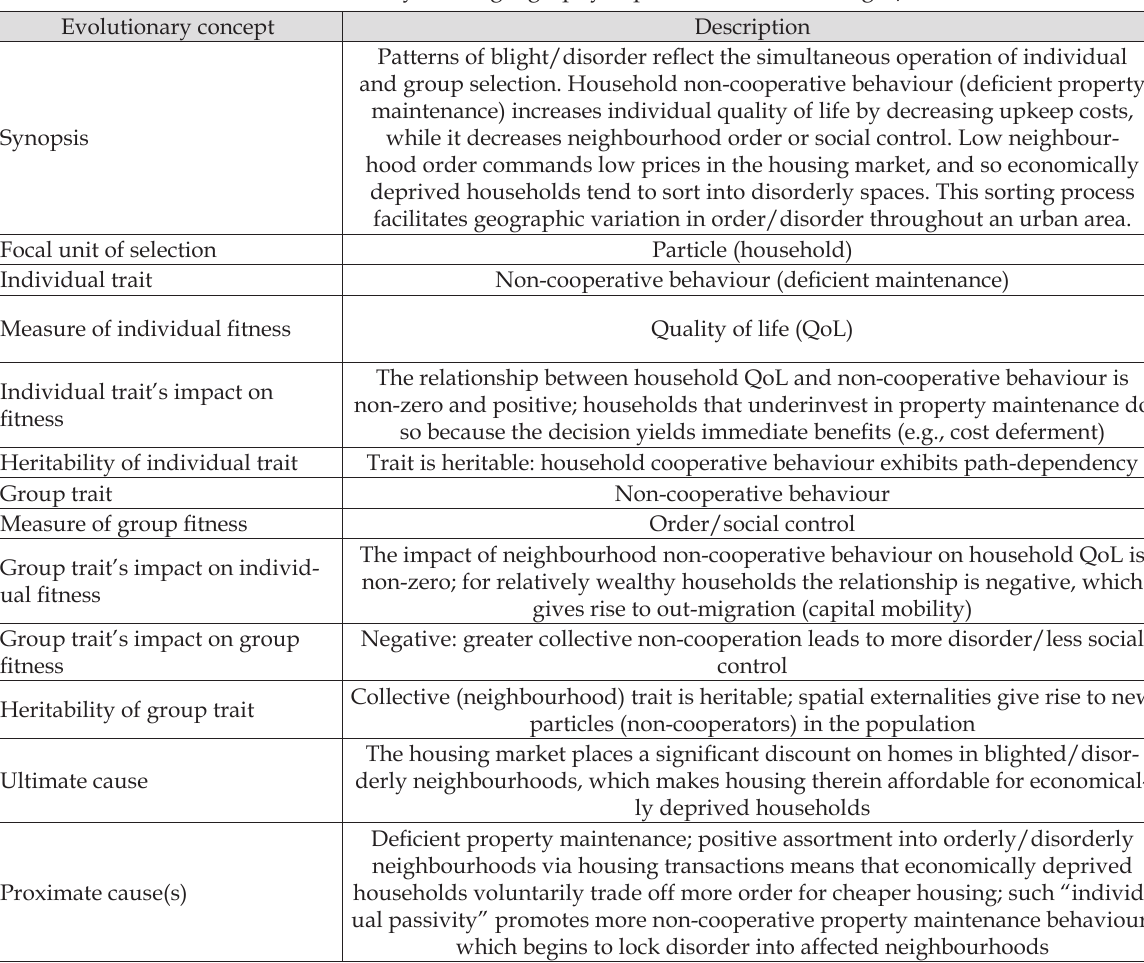
Table 1. An evolutionary urban geography explanation of urban